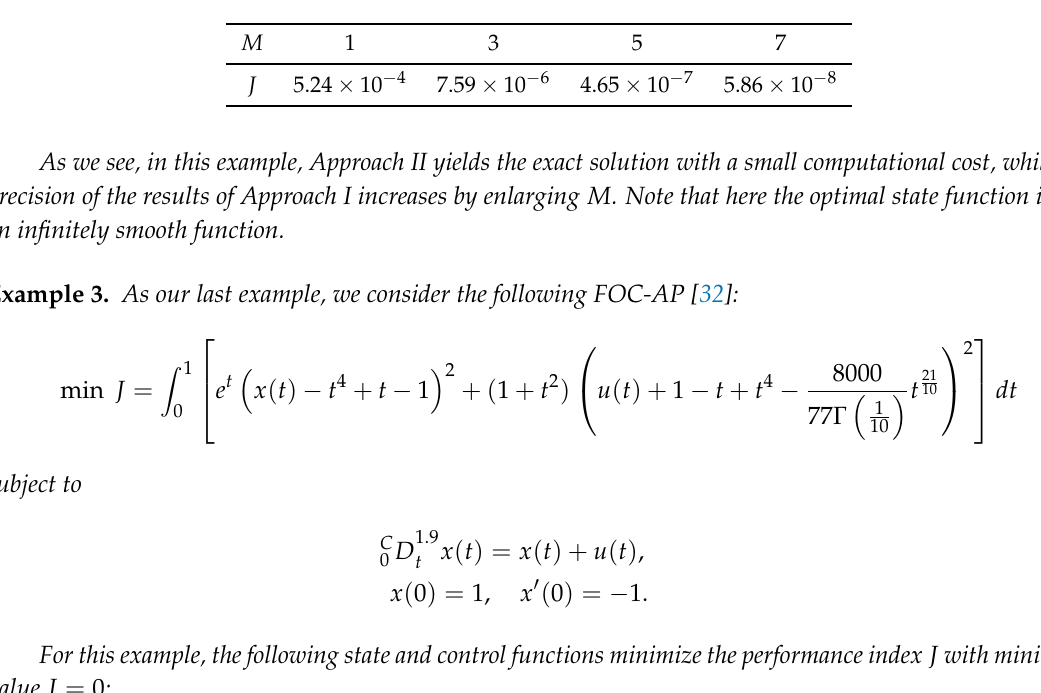
Figure 3. (Example 2.) Comparison between the exact and approximate state ( left ) and control ( right ) functions obtained by Approach I with different values of M . Table 3. (Example 2.) Numerical results for the performance index obtained by Approach I with different M